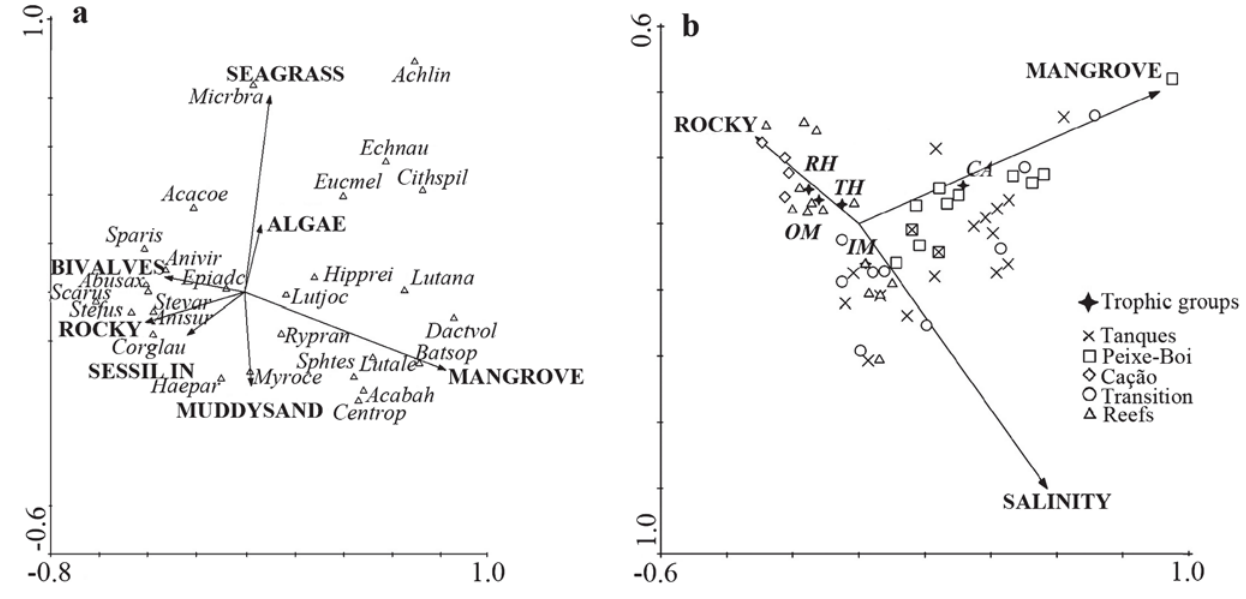
Fig. 3. Canonical Correspondence Analysis of fishes and environmental parameters from Mamanguape Mangrove-Reef system, NE Brazil: ( a ) fish species (symbols) in relation to microhabitat categories (vectors) - Eigenvalues: axis 1, 0.56; axis 2, 0,20; r species-environment: axis 1, 0.87; axis 2, 0.56; First two axes accounted for 64.9 % of the variance; ( b ) fish trophic groups and sub- areas (symbols) in relation to environmental categories (vectors) - Eigenvalues: axis 1, 0.49; axis 2, 0.39; r species-environment: axis 1, 0.79; axis 2, 0.76; First two axes accounted for 51.6 % of the variance. Monte-Carlo test of all canonical axes were significant ( p < 0.01), 999 permutations. Abbreviations as follows - fish species: Abusax : Abudefduf saxatilis ; Acabah : Acanthurus bahianus